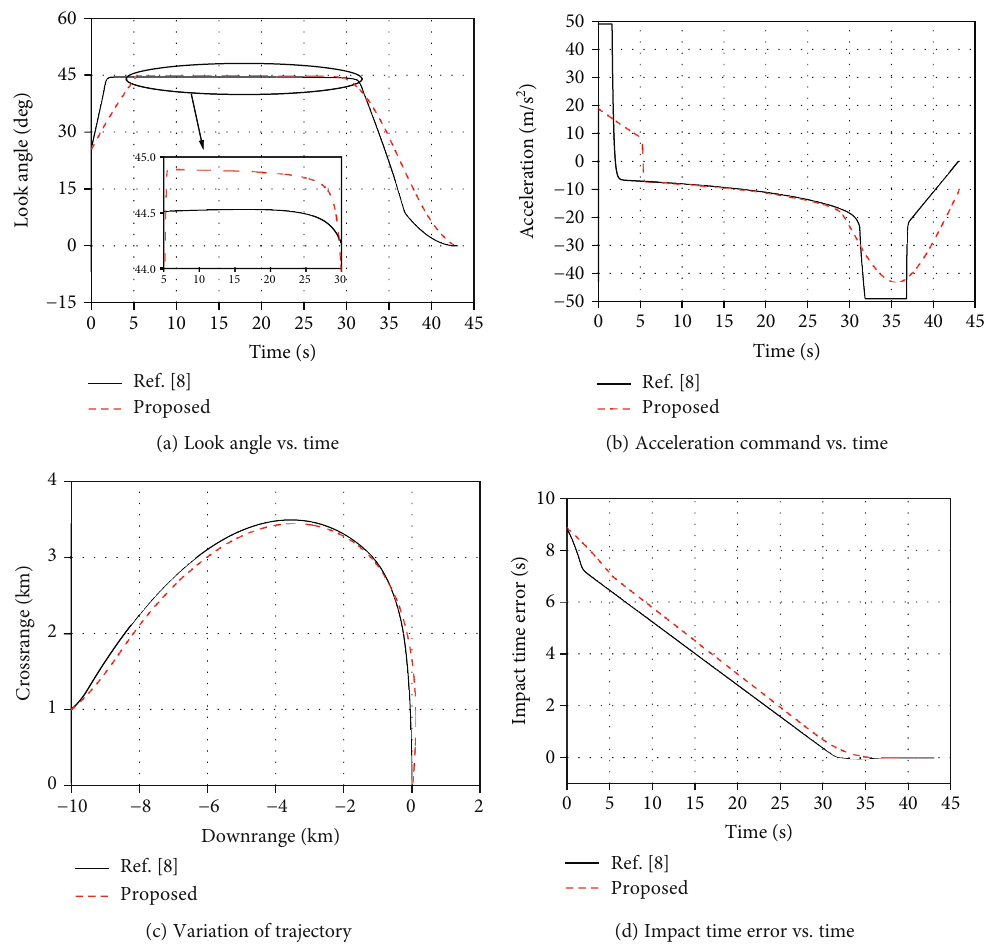
Figure 6: Simulation of ITCG laws in the case of t